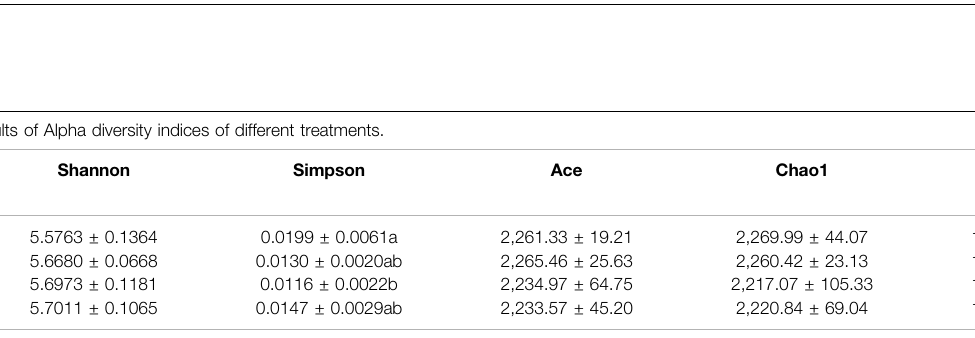
FIGURE 1 | Comparison of the bacterial communities in different treatments based on OTU numbers. (A) Venn diagram of OTU numbers for different treatments. Everycircleindicatesatreatment;thenumberofOTUssharedbetweendifferenttreatmentswasinterpretedwiththenumberintheoverlappingcircles,whilethenumber in the non-overlapping area represented the number of unique OTUs for the speci fi c treatment. (B) Rarefaction curves of bacterial communities for all treatments.